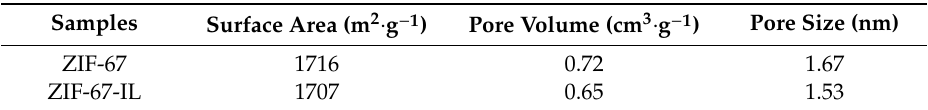
Figure 5. Nitrogen adsorption-desorption isotherms for ZIF-67 and ZIF-67-IL. Table 1. Texture structure of the synthesized zeolitic imidazolate framework (ZIF-67) and ionic-liquid-modified ZIF-67 (ZIF-67-IL).